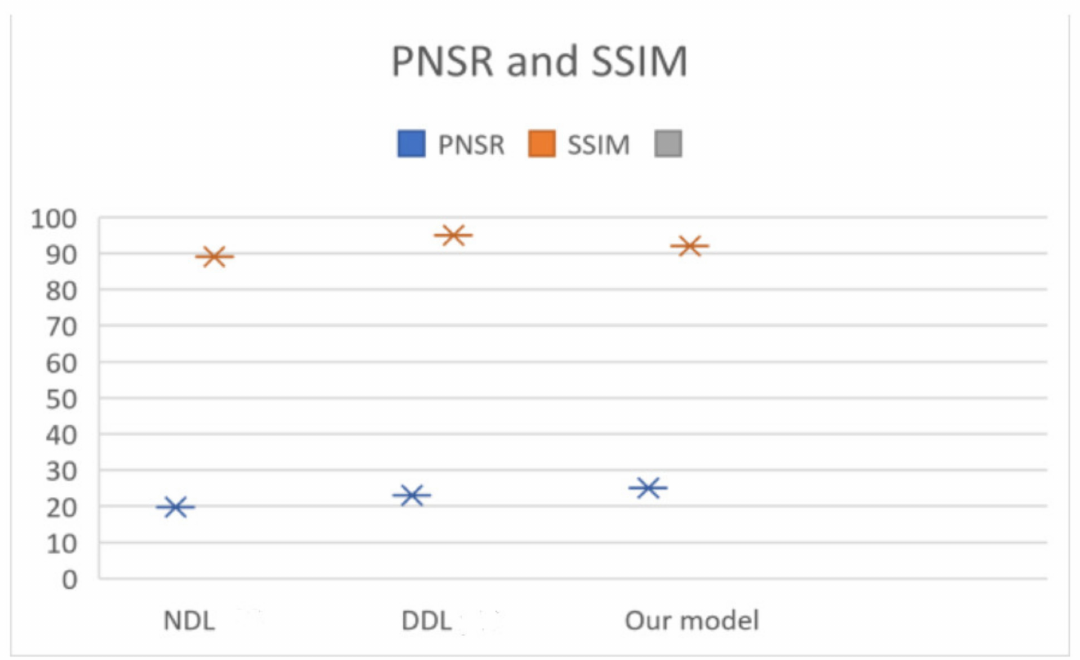
Figure 19. PSNR and SSIM